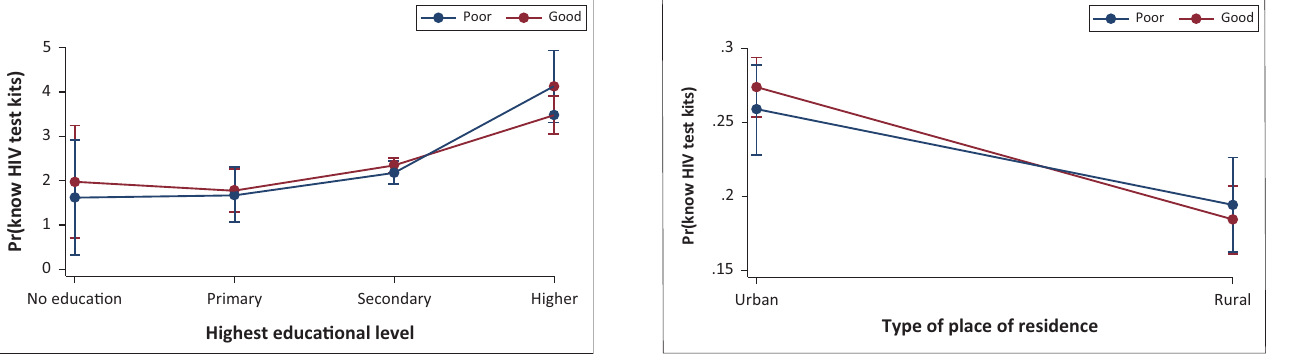
FIGURE 1: Predictive marginal effects of HIV test kits knowledge by educational level and HIV infection knowledge.